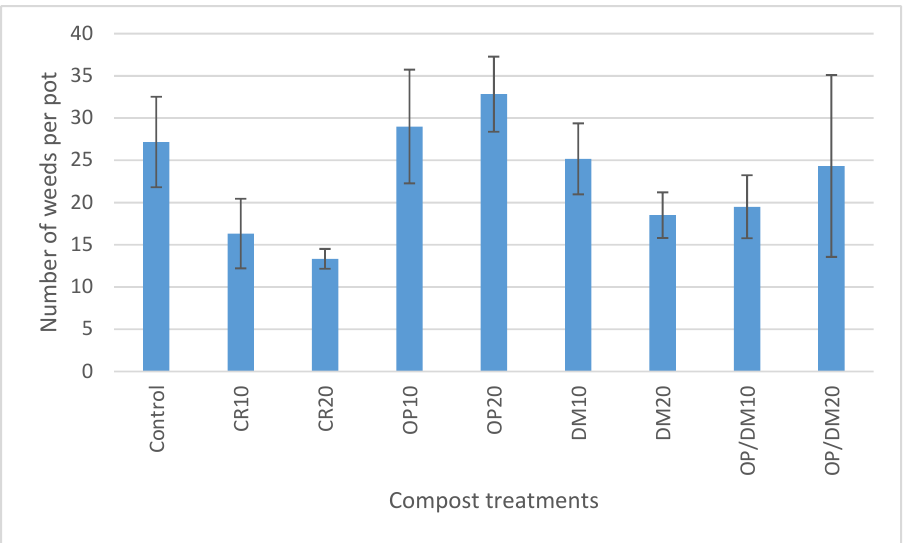
Figure 5. Number of weeds per pot as affected by different compost sources and rates. Error bars represent ± standard error ( P = 0.23, n = 6).